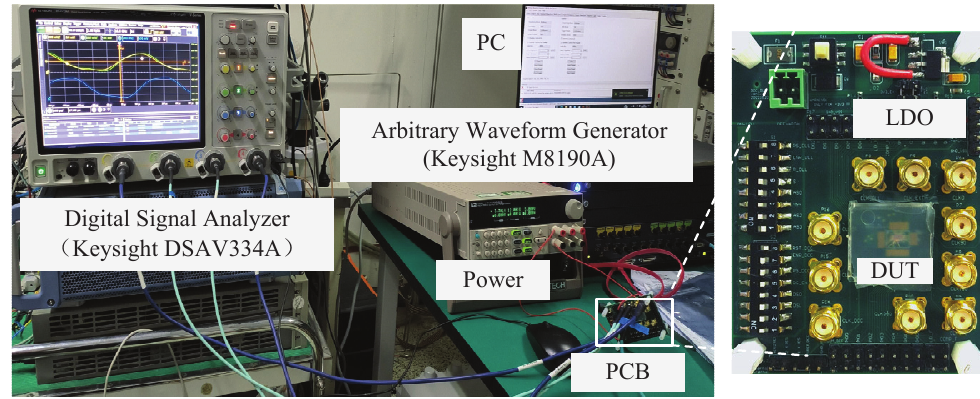
Figure 13. The testbench of proposed DLL.